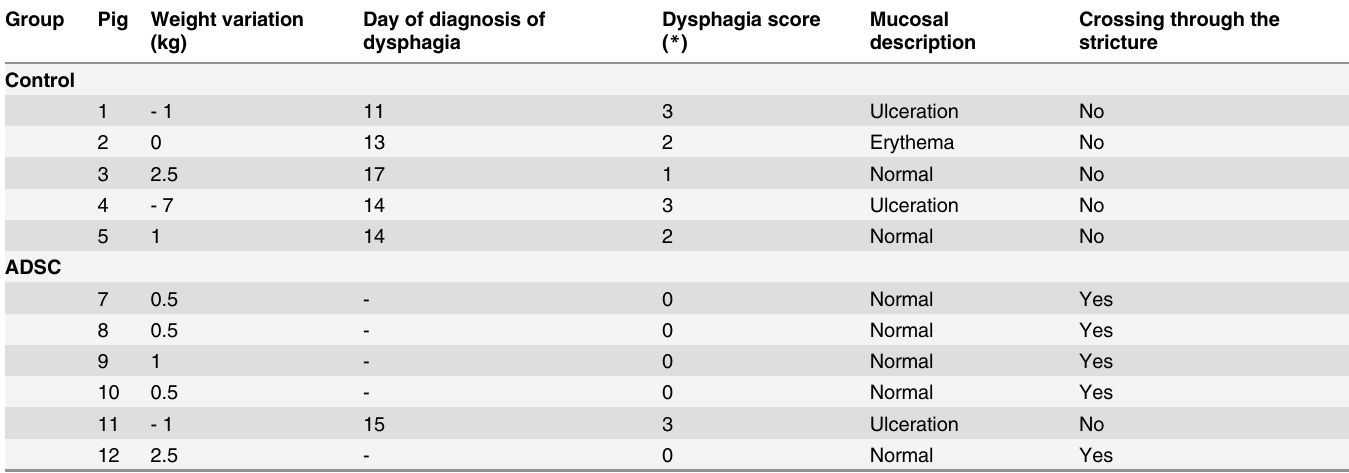
Table 1. Clinical and endoscopical results on day